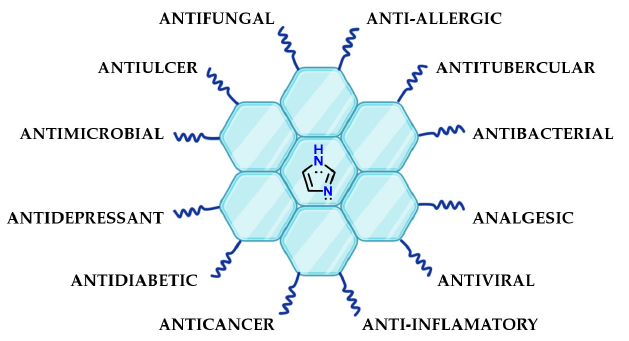
Figure 30. Presence of imidazole 1 in the most diverse classes of bioactive compounds.